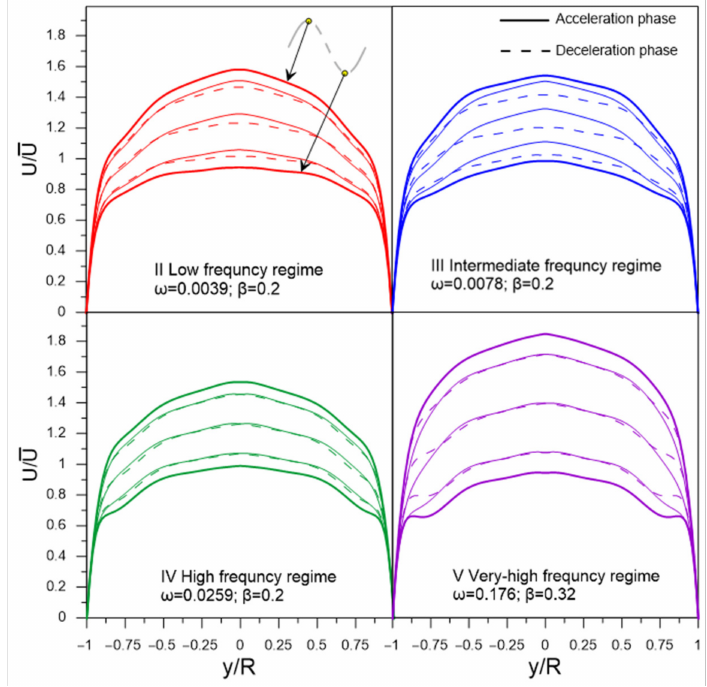
Figure 6. Reconstructed dynamics of velocity